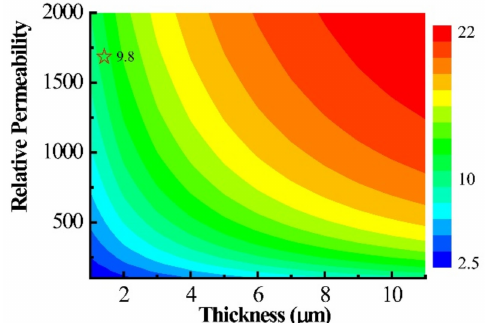
Figure 3. The magnetic magnification of the double-gap MFC ( l g = 20 µ m) dependence on the relative permeability and MFC